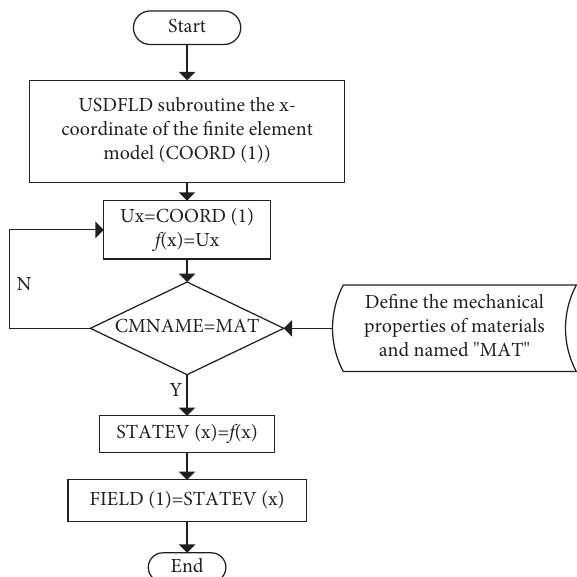
Figure 8: The flowchart of USDFLD